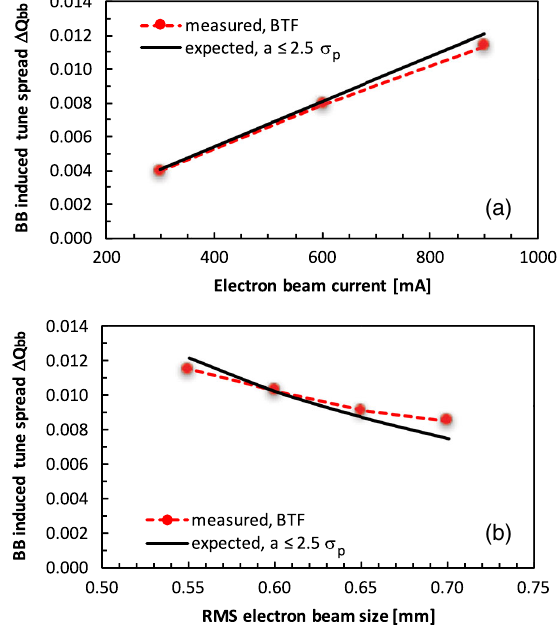
FIG. 16. Comparison of measured and calculated increase in the tune spread of the electron lens in an electron beam current scan (a) and electron beam size scan (b). The measured width of the tune distribution is taken at j Im ð R Þ = ð R Þj ¼ 0 . 1 , the calcu- lation is for an amplitude range a from zero to 2.5 σ